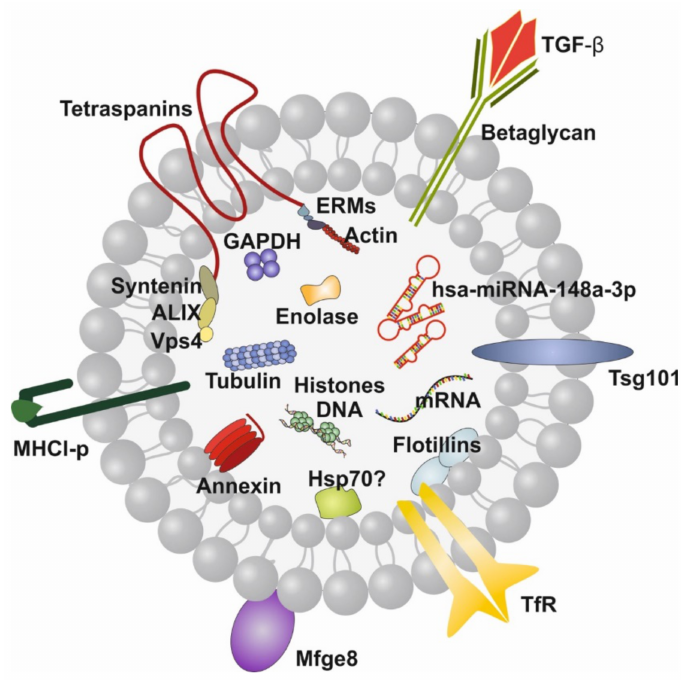
Figure 1. Illustration of a human milk exosome (MEX). The bilayer membrane is important for MEX resistance against the harsh conditions in the gastrointestinal tract. hsa-miRNA-148a-3p is the dominant miRNA of MEX. Note, MEX also contain transforming growth factor- β (TGF- β ). Tetraspanins are CD9, CD63, CD81 and